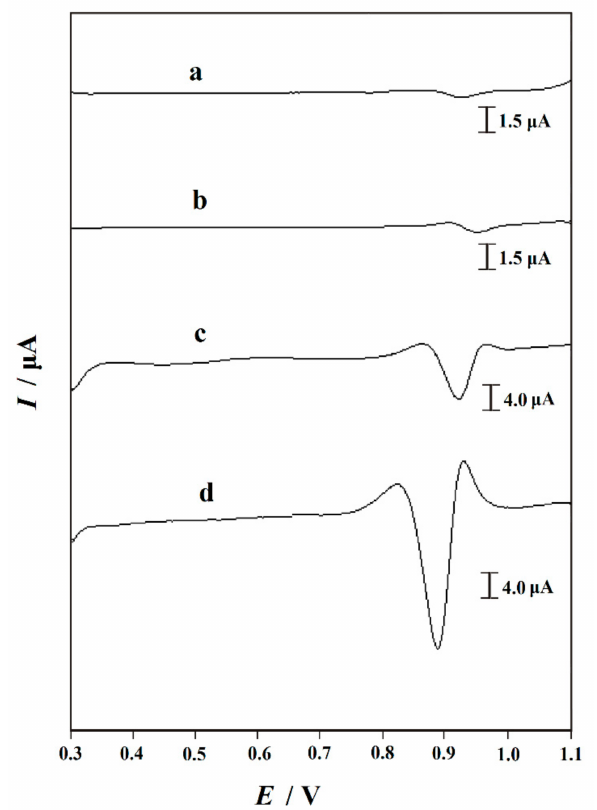
Figure 3. Second derivative linear sweep voltammograms (SDLSVs) of 10 µ M tryptophan (Trp) in 0.1 M phosphate bu ff er (pH 2.2) recorded at ( a ) bare GCE; ( b ) PVP / GCE; ( c ) GR / GCE and ( d ) PVP-GR / GCE. Accumulation potential: 0.0 V, accumulation time: 60 s, scan rate: 0.1 V s − 1